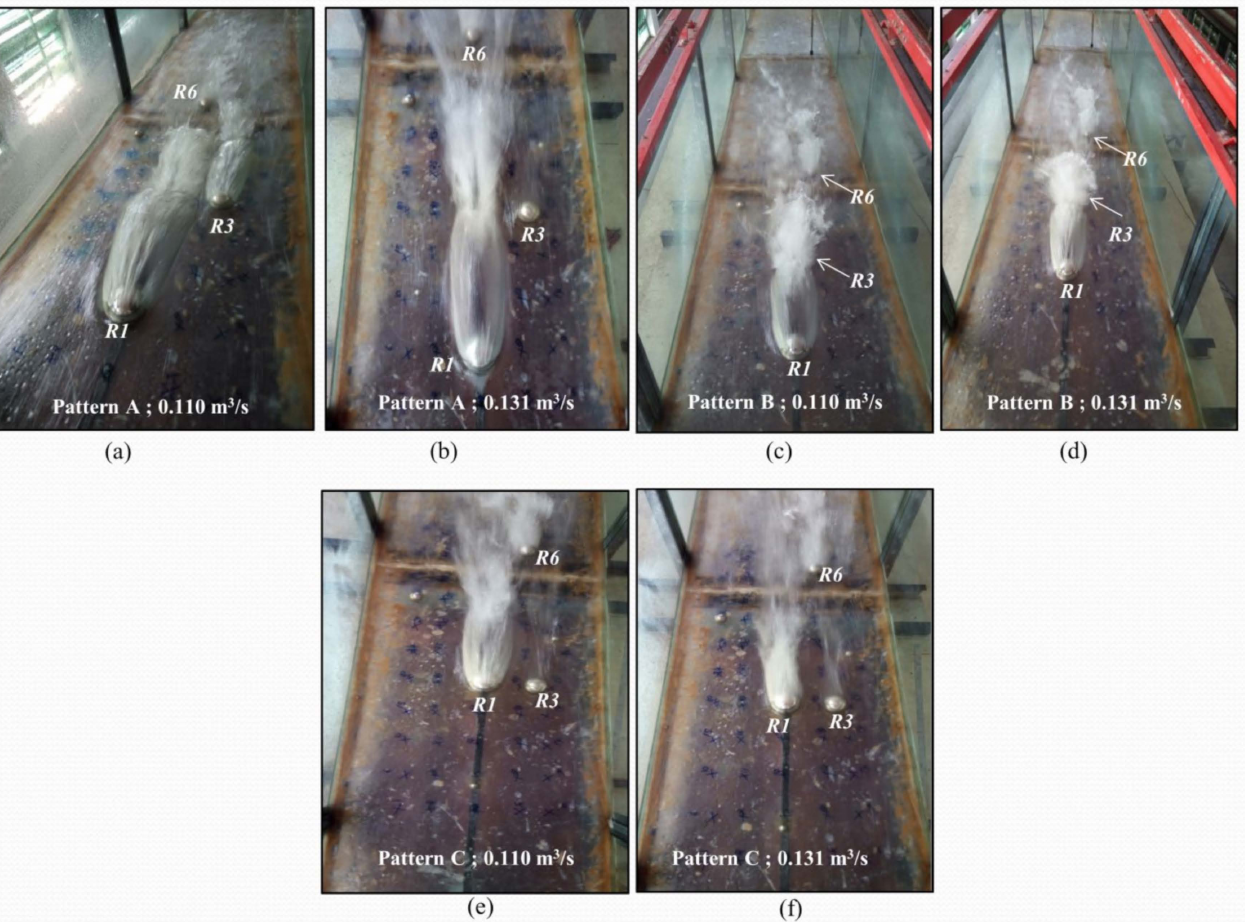
Figure 3. Experimental images: ( a ) pattern A, Q = 0.110 m 3 /s; ( b ) pattern A, Q = 0.131m 3 /s; ( c ) pattern B, Q = 0.110 m 3 /s; ( d ) pattern B, Q = 0.131 m 3 /s; ( e ) pattern C, Q = 0.110 m 3 /s; ( f ) pattern C, Q = 0.131 m 3